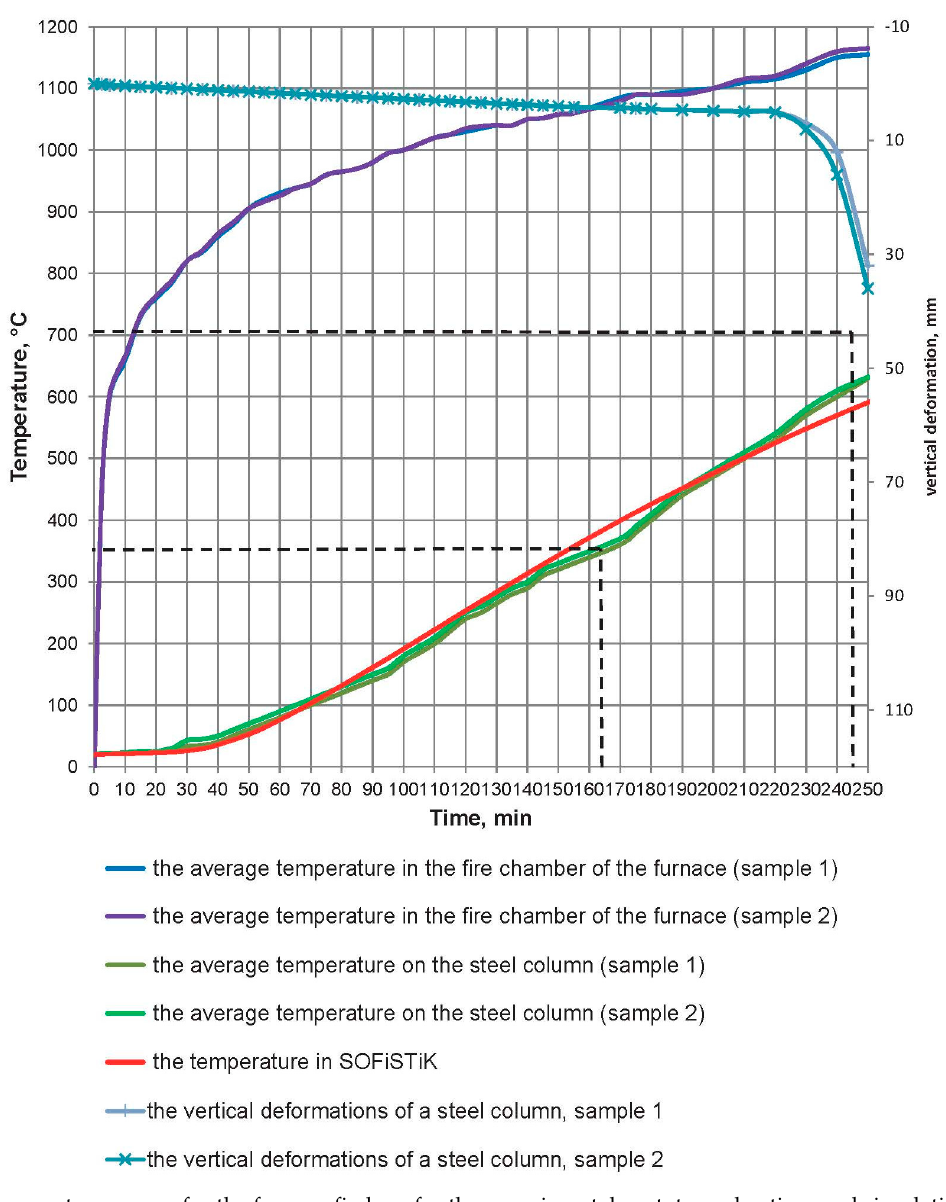
Figure 12. Temperature curves for the furnace firebox, for the experimental prototypes heating, and simulation values for standard fire.